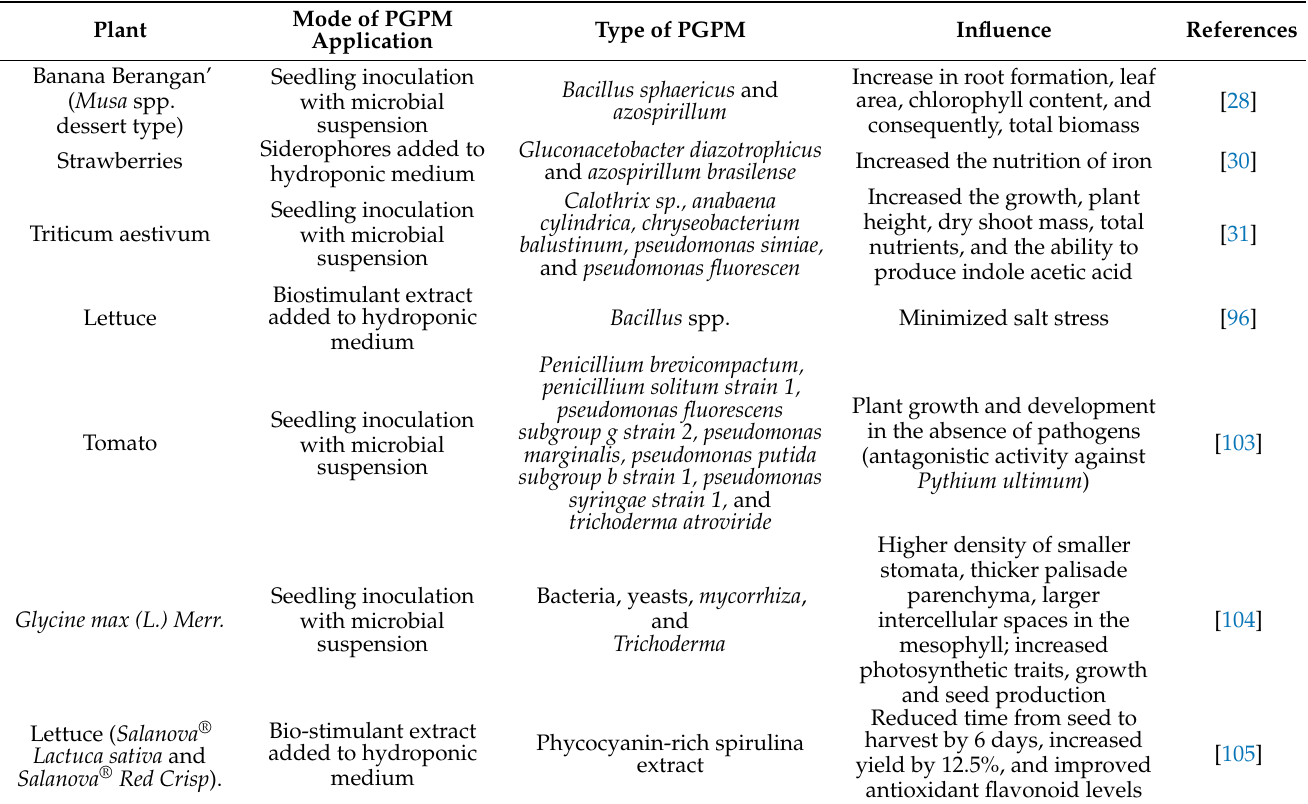
Table 1. Previous studies on plant growth-promoting microorganisms’ (PGPMs) mode of application in a soil-free system, plant types used, and their